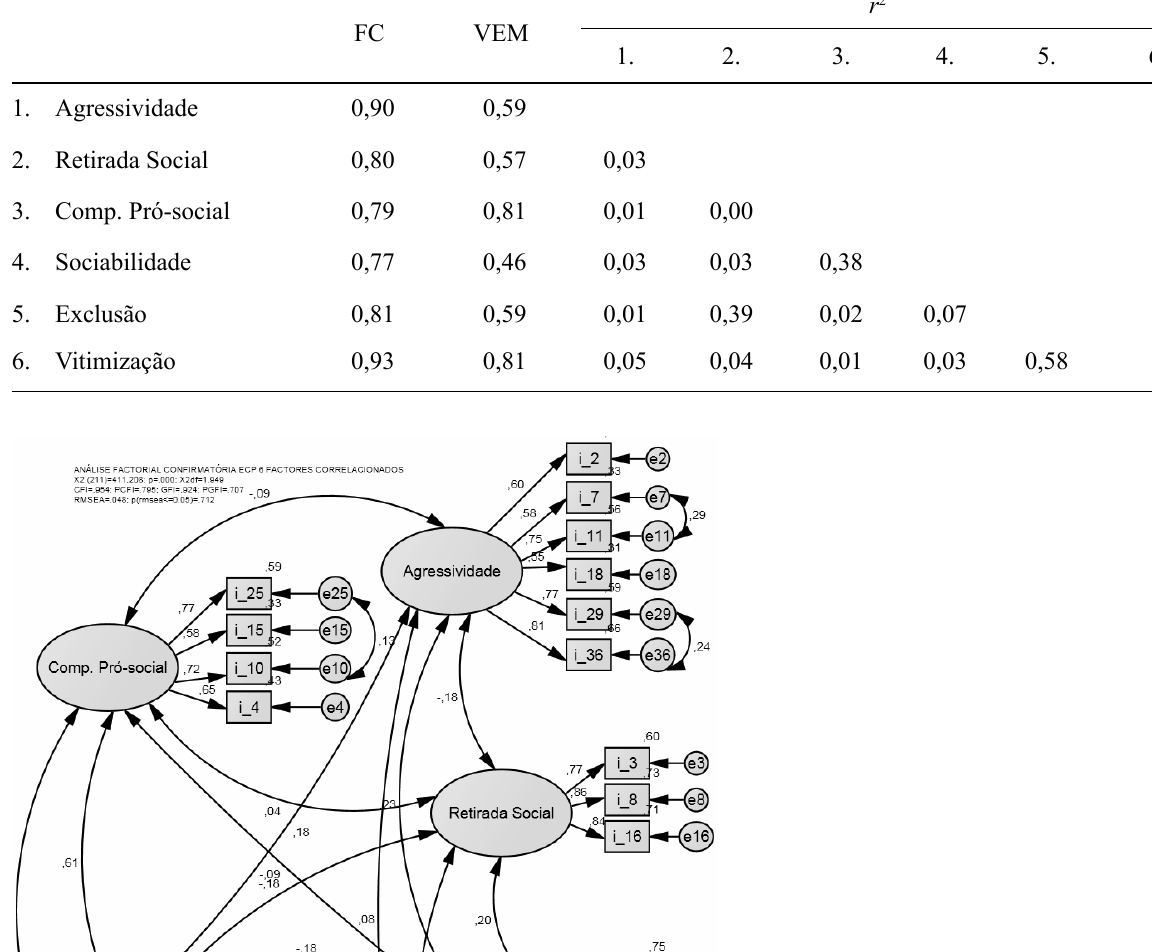
Figura 1 . Modelo fi nal do ECP ajustado a uma amostra de 465 adolescentes